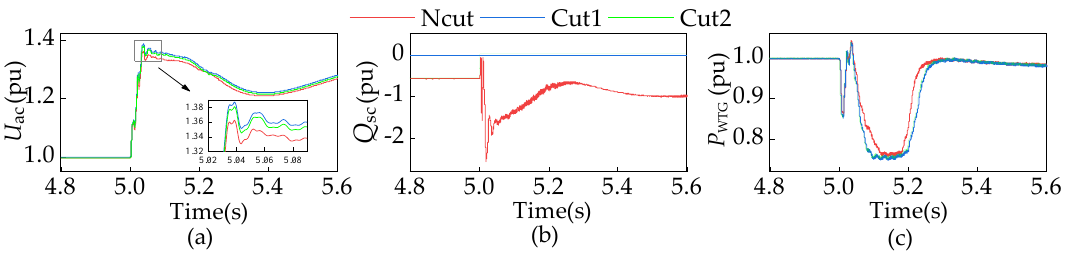
Figure 9. Simulation results during the overvoltage condition: ( a ) Bus voltage of the rectifier side; ( b ) Reactive power of SC; ( c ) Active power of the WTG on the rectifier side. 428